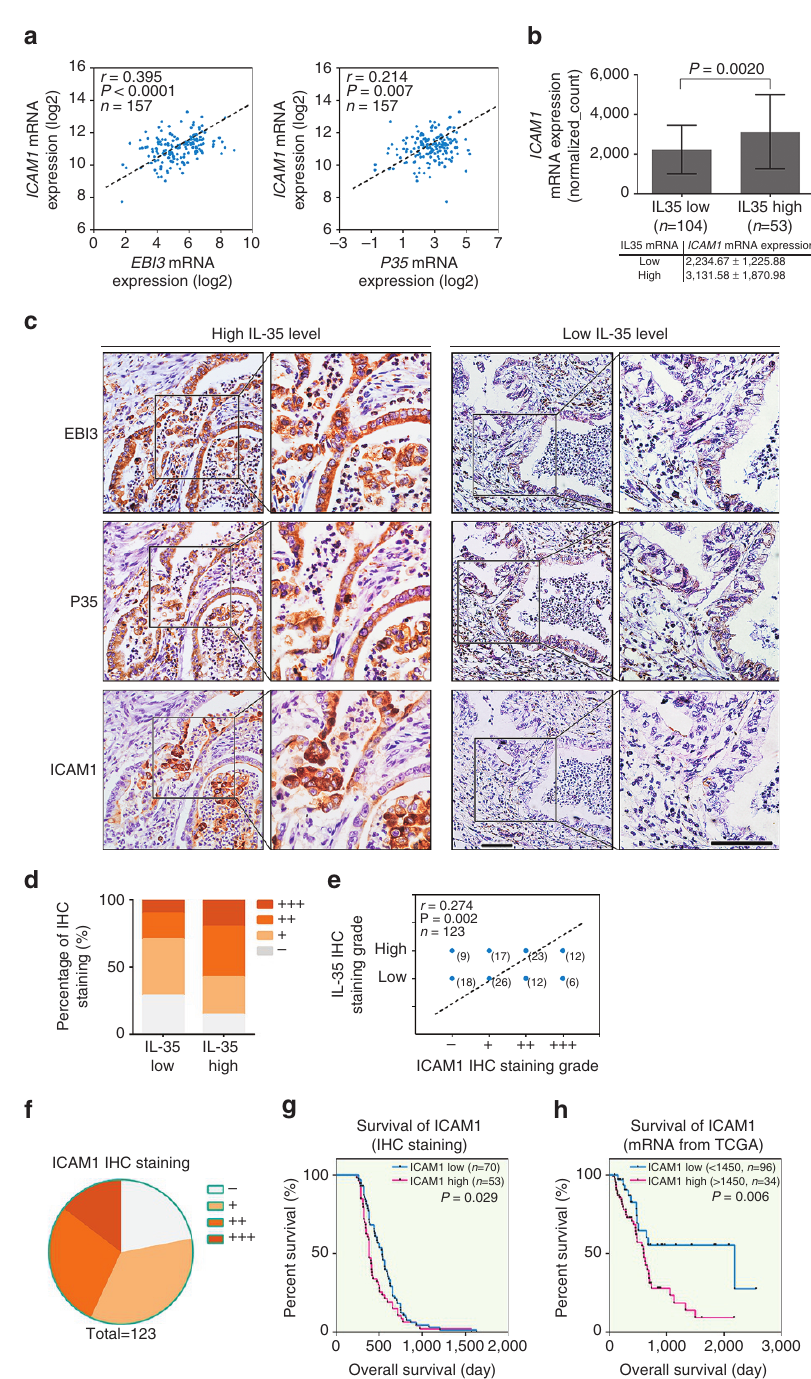
Figure 5 | Correlation between ICAM1 and IL-35 expression in human PDAC tissues. ( a ) Spearman’s correlation analysis of the mRNA expression profiles of EBI3 and ICAM1 (left), as well as P35 and ICAM1 (right), in 157 PDAC patients from TCGA. ( b ) The 157 patients were stratified into two groups on the basis of the mRNA level of EBI3 and P35 : IL-35 high, both EBI3 and P35 mRNA levels higher than median; others were IL-35 low. The ICAM1 mRNA levels of the two groups are presented. Unpaired t -tests were used; shown are the mean values ± s.d. ( c ) Representative IHC staining images of high and low levels for ICAM1, EBI3 and P35 in consecutive sections are shown. Figure panels pairs represents images taken with different zooming options; scale bars, 100 m m. ( d ) Real distribution of IHC results between ICAM1 and IL-35 expression. ( e ) Spearman’s correlation analysis of ICAM1 and IL-35 IHC staining results in 123 human PDAC surgical samples. ( f ) Real distribution of immunohistochemical results of ICAM1 in 123 PDAC tissues. ( g ) Kaplan–Meier analysis of OS of 123 PDAC patients according to different ICAM1 levels by IHC staining (ICAM1 low, (cid:2) / þ ; ICAM1 high, þ þ / þ þ þ ). ( h ) mRNA profiles and follow-up data of 130 PDAC patients from TCGA analysed for the correlation of the ICAM1 mRNA expression and survival. Log-rank tests were used in g and h . Tests of significance are two-sided; * P o